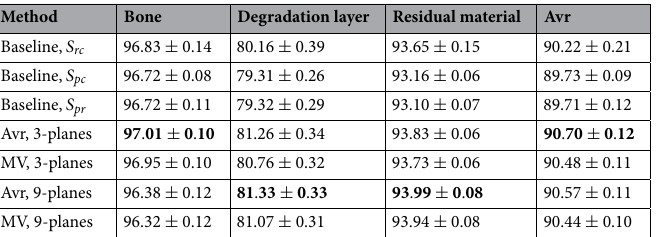
Figure 3 summarizes the results for scaling each parameter of the base- line model separately (i.e., depth, width, and input size) and for scaling multiple parameters simultaneously